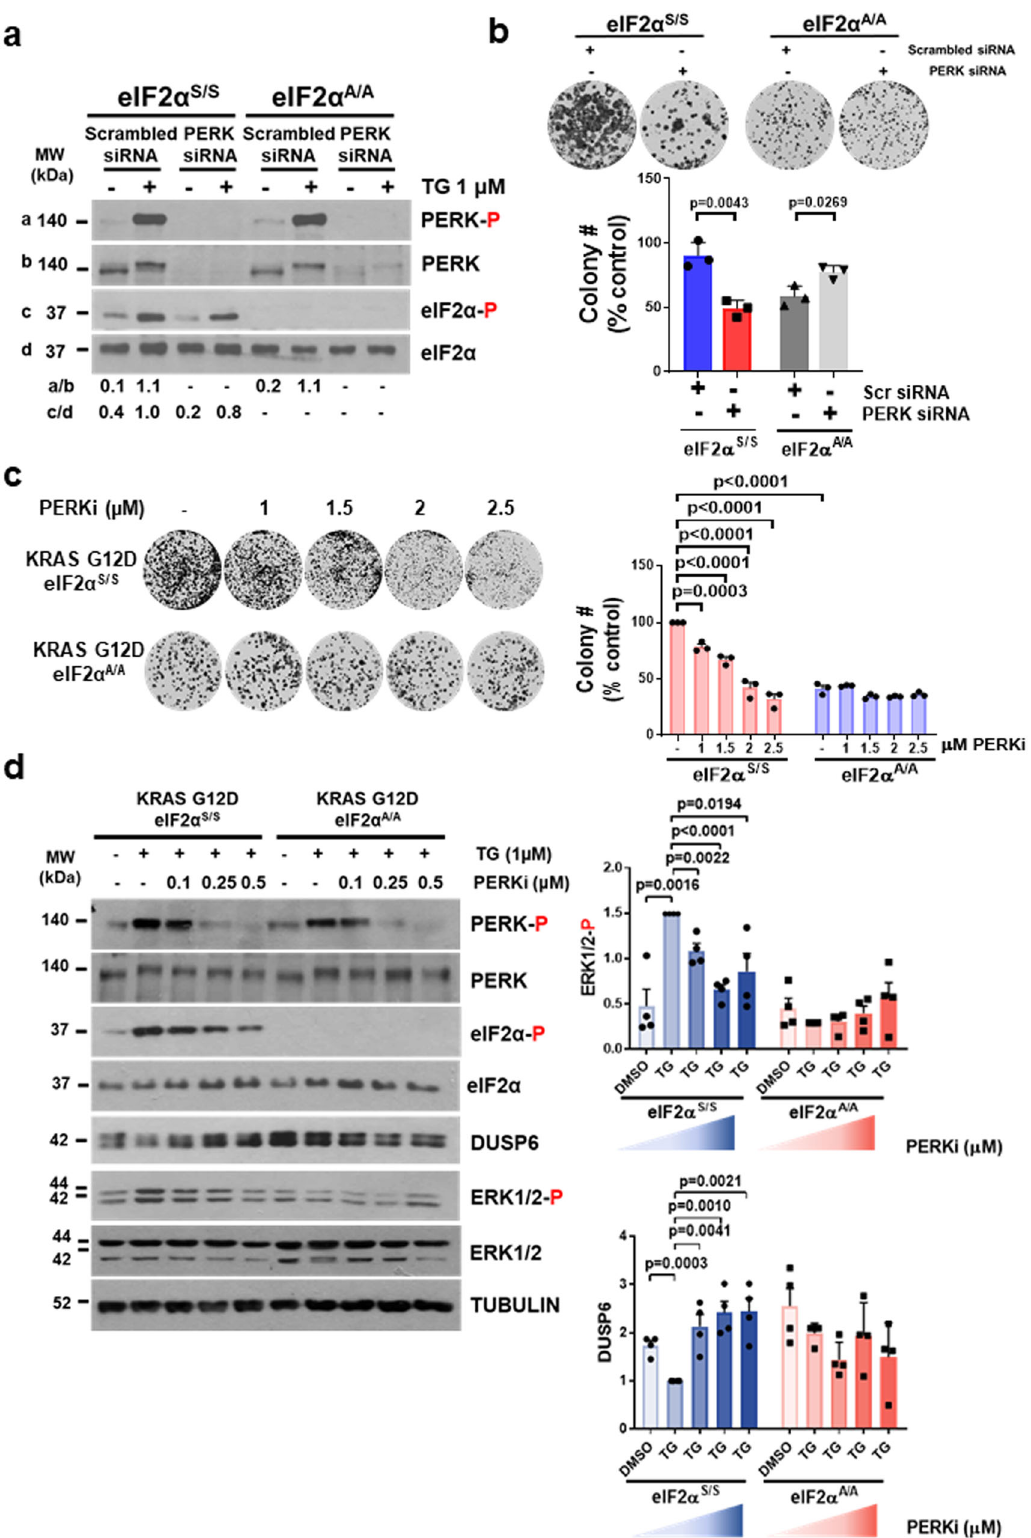
2-related factor 2 (NRF2)-HIF pathway in pancreatic and lung cancers 54